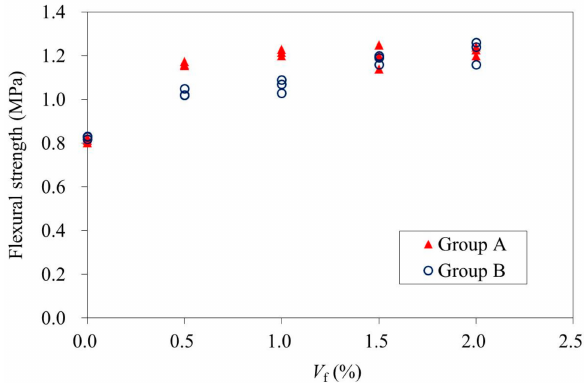
Figure 10. Flexural strengths of specimens having different fiber volume